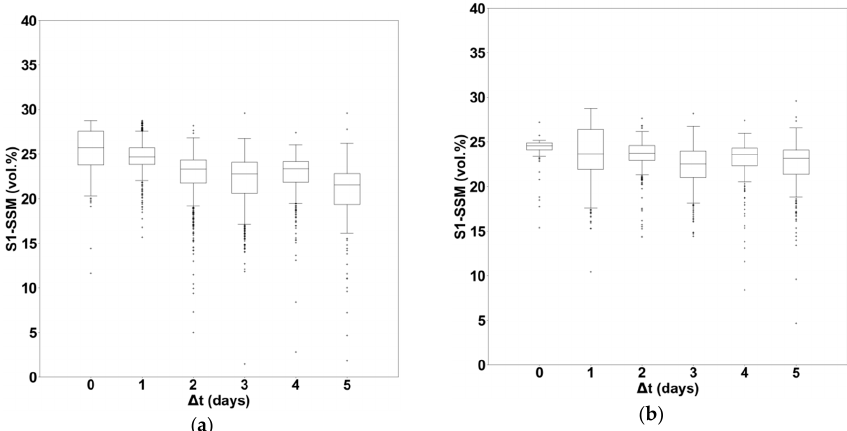
Figure 7. S1-SSM distribution as a function of the number of days that separate the heavy rainfall event and the acquisition date of S1. ( a ) Heavy rainfall with 60 mm of cumulative precipitation in 24 hours, ( b ) heavy rainfall with 80 mm of cumulative precipitation in 48